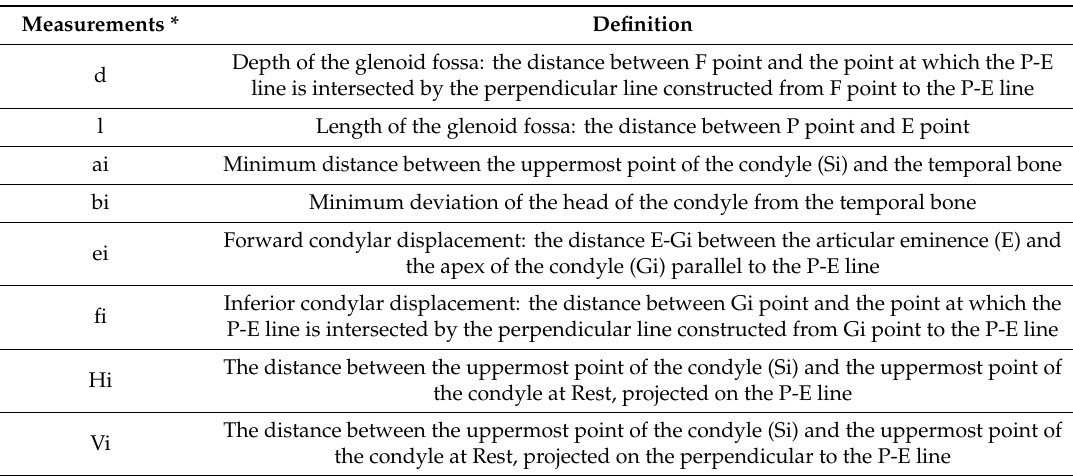
Table 2. Main relevant measurements that are useful for investigating the TMJ kinematics. * The subscript number refers to the i-th configuration.